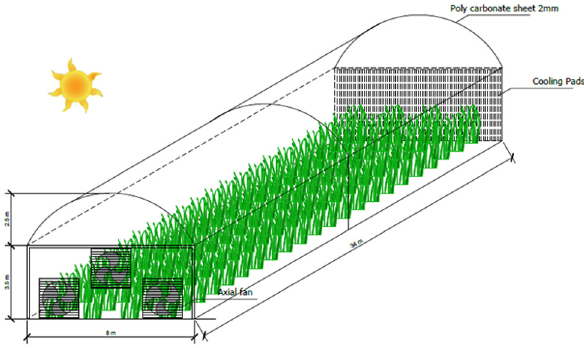
Figure 2: 3D view of the exterior of the conventional greenhouse ventilation.